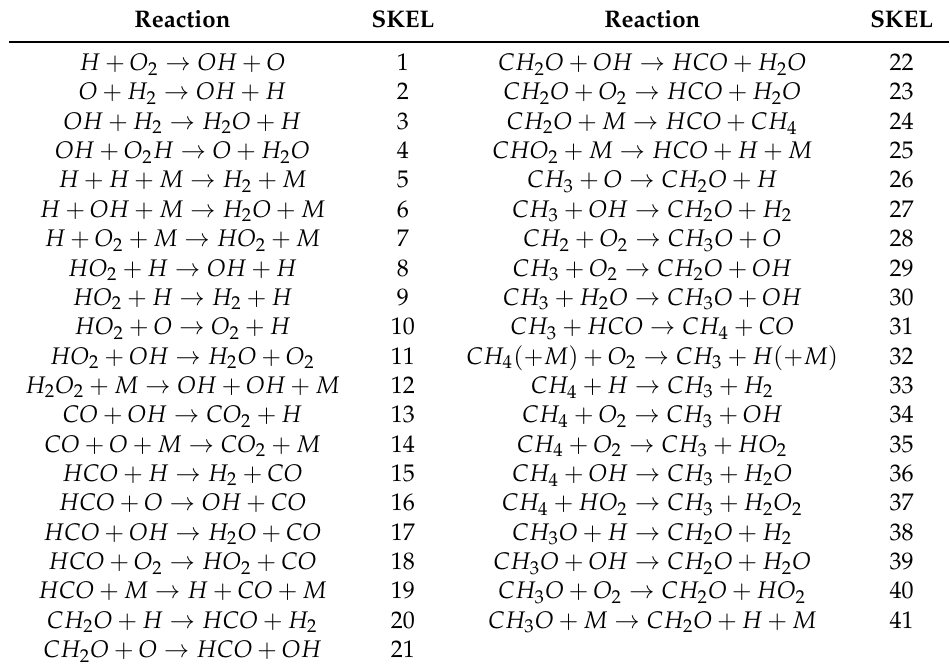
Table 1. Reactions of the skeletal (SKEL) kinetic mechanism